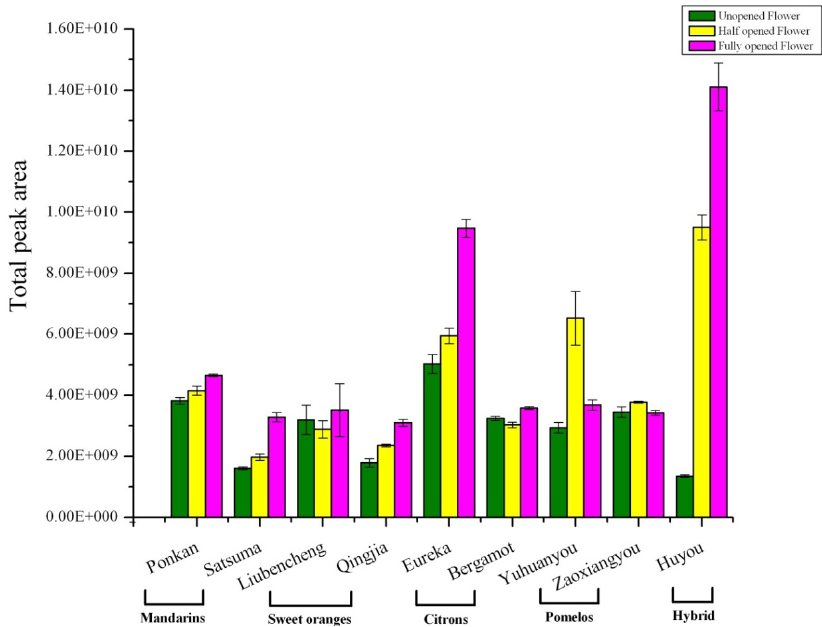
Figure 1. Total volatile contents of unopened, half opened and fully opened flower of five citrus